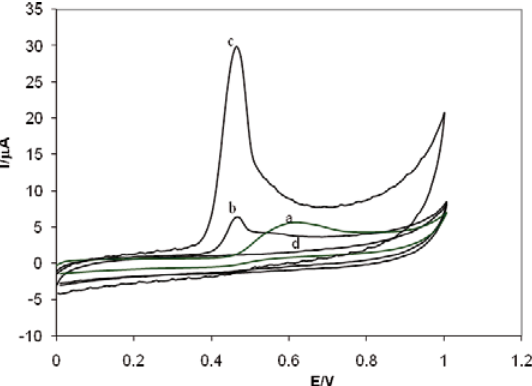
Figure 1. Cyclic voltammograms of 1.9 × 10 -5 M Piroxicam at a carbon paste electrode modifi ed with zeolite (a), bare carbon ceramic electrode (b) and zeolite modifi ed carbon ceramic electrode (c), in 0.2 M buffer phosphate (pH=7) with scan rate of 30 mV s -1 . The voltammogram of (d) is a